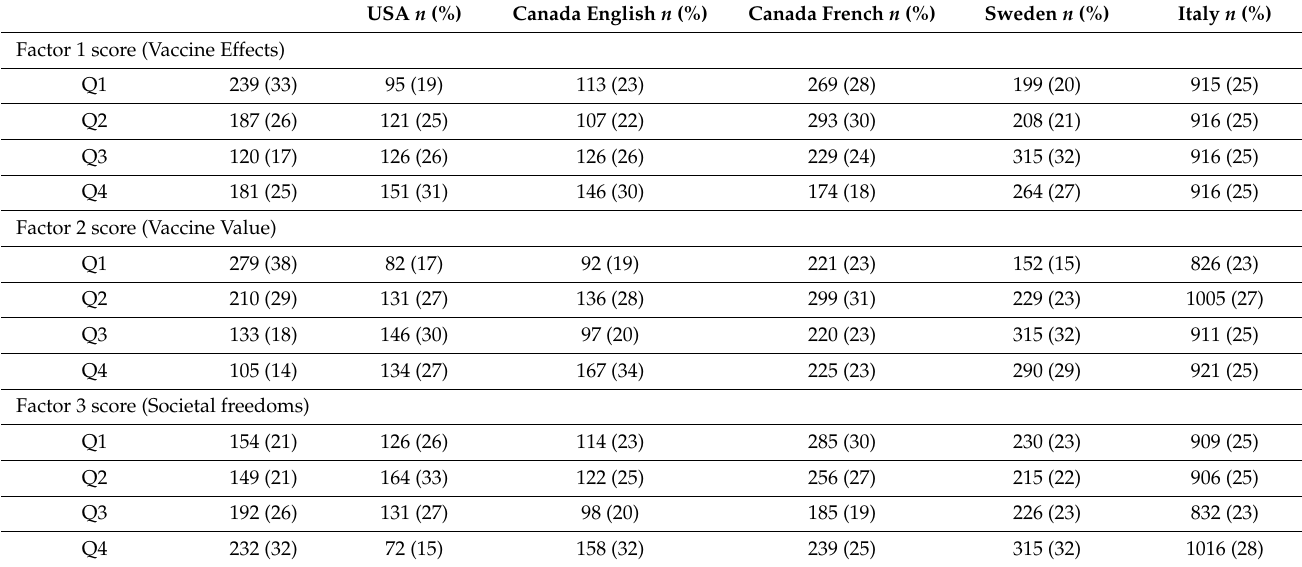
Table A2. Quartles of Factor Scores by Country-Language